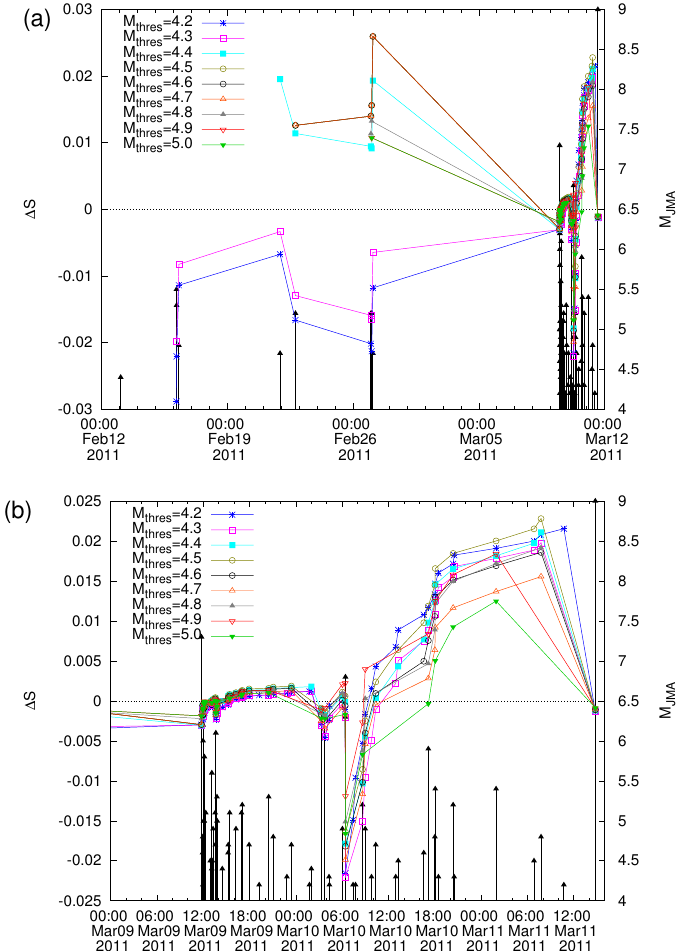
Figure 10. The evolution of the ∆ S values of seismicity (left scale) in the blue-green area of Figure 7 almost a month ( a ) and two-and-a-half days ( b ) before the M 9 Tohoku EQ on 11 March 2011, i.e., the same periods as those depicted in Figure 8 for the evolution of the κ 1 value. Concerning the importance of the appearance of the minimum of ∆ S , which is evident in ( b ), see the fulfillment of the criteria for the approach to criticality discussed in Section